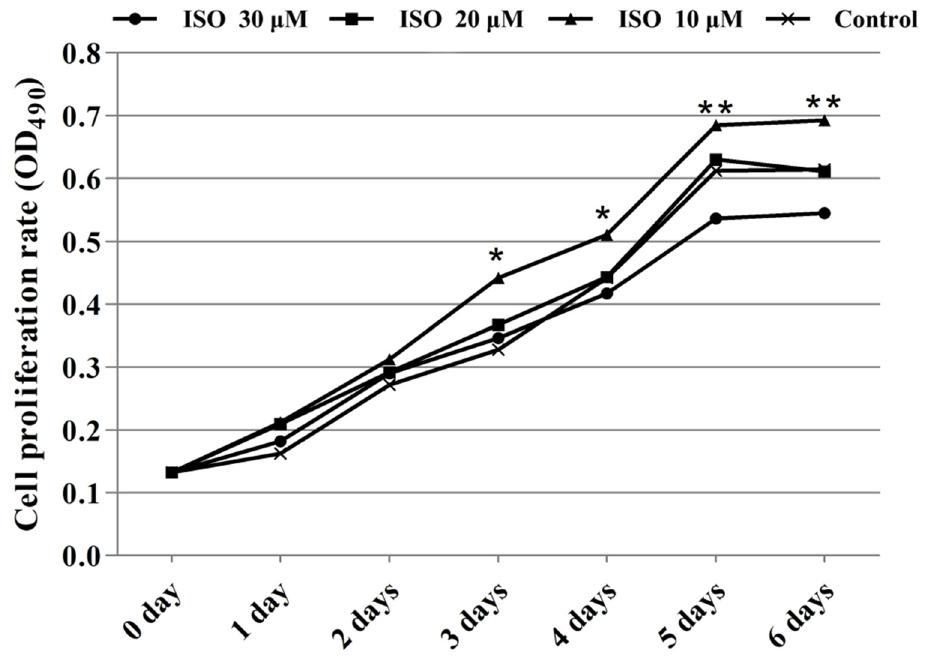
Figure 3. Effects of ISO on cell proliferation from day 0 to day 6. Groups indicated by * ( p < 0.05) or ** ( p < 0.01) differ significantly compared to control.